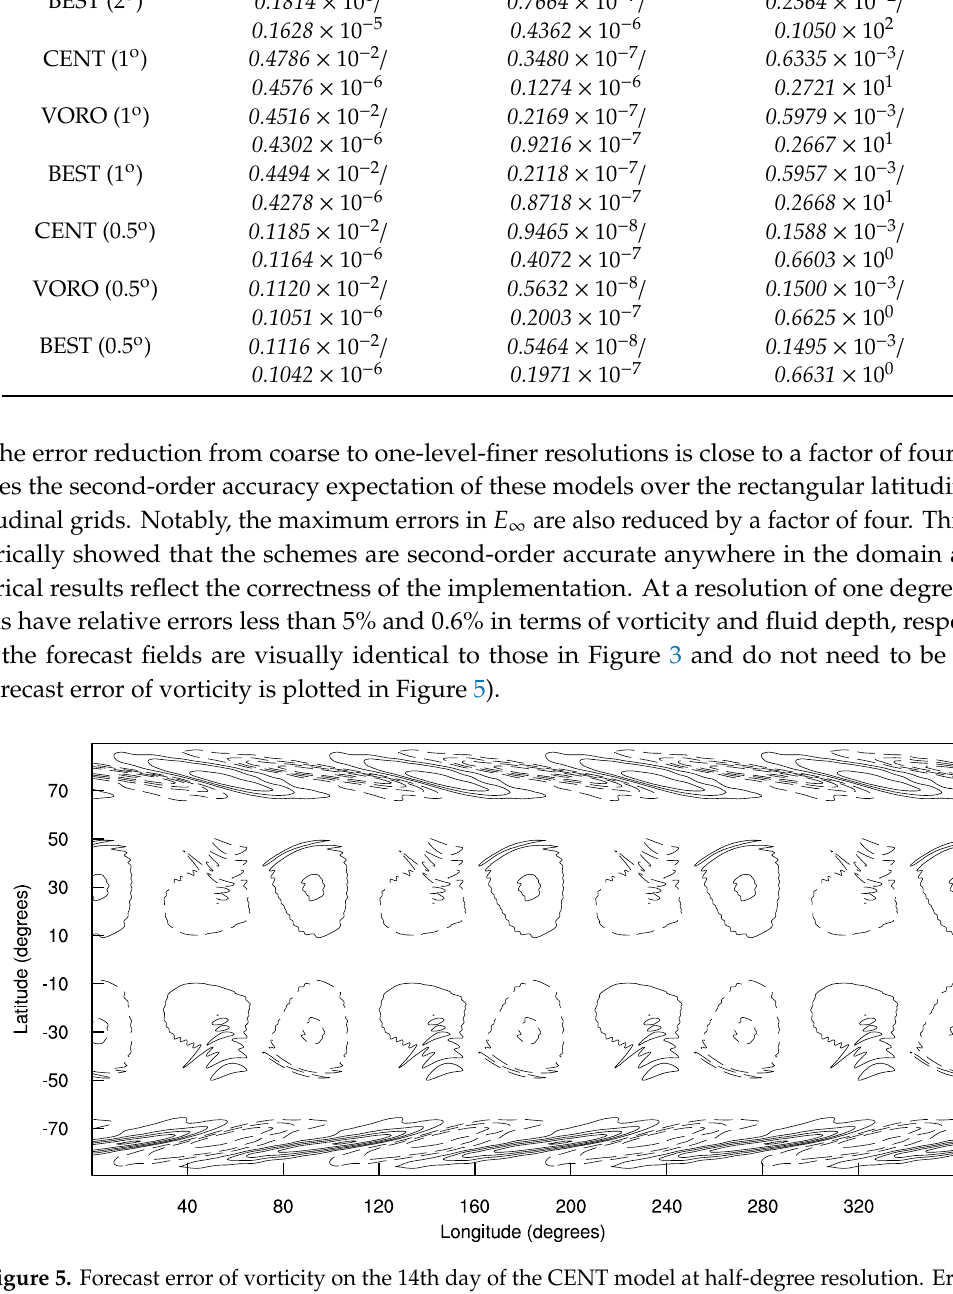
Figure 5. Forecast error of vorticity on the 14th day of the CENT model at half-degree resolution. Error sizes are in the range of ( − 10 − 7 , 10 − 7